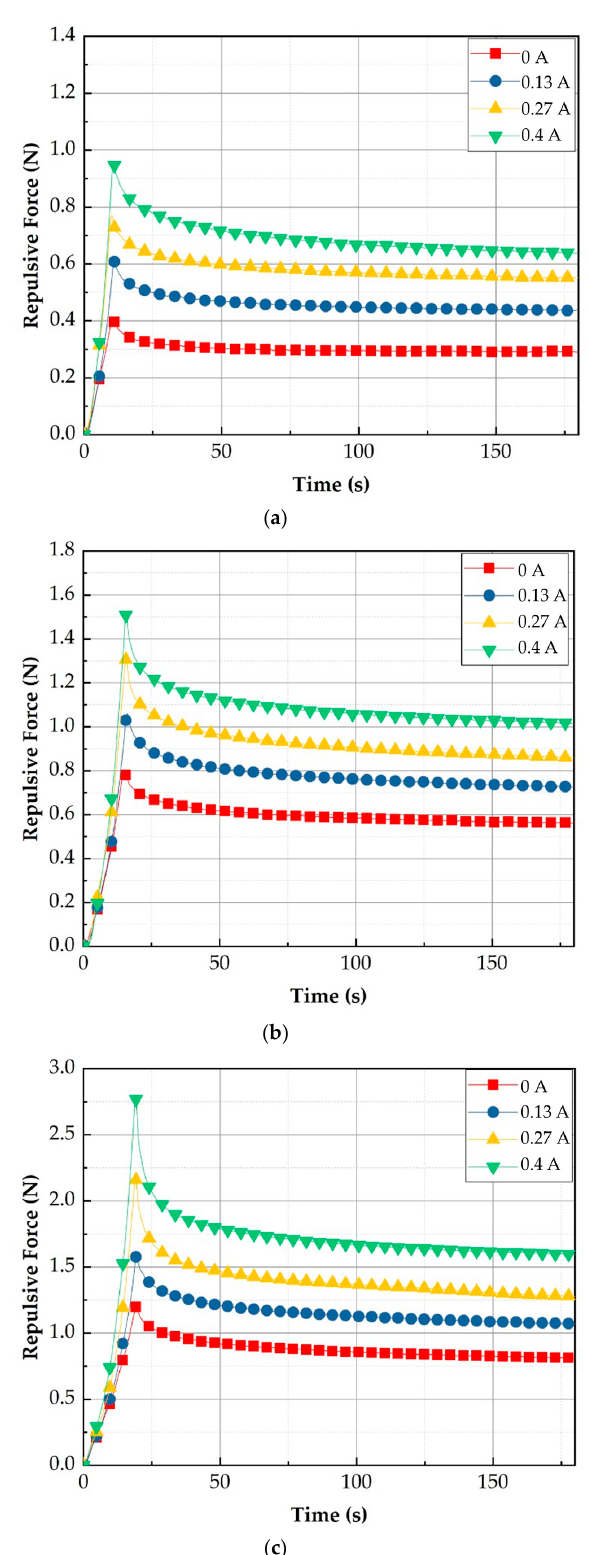
Figure 12. Measured repulsive forces at different compressive deformation depths: ( a ) 4 mm com- pression, ( b ) 6 mm compression, ( c ) 8 mm compression.